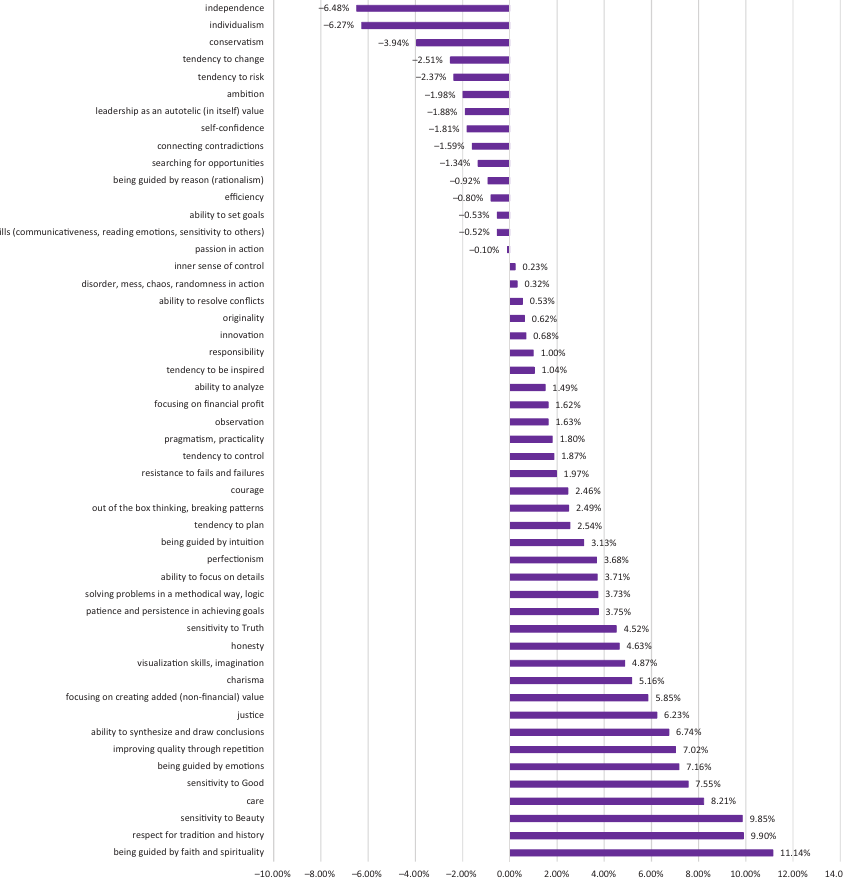
Figure 9. Perception of the 50 features of a leader’s identity by artistic versus non-artistic individuals (source: created by